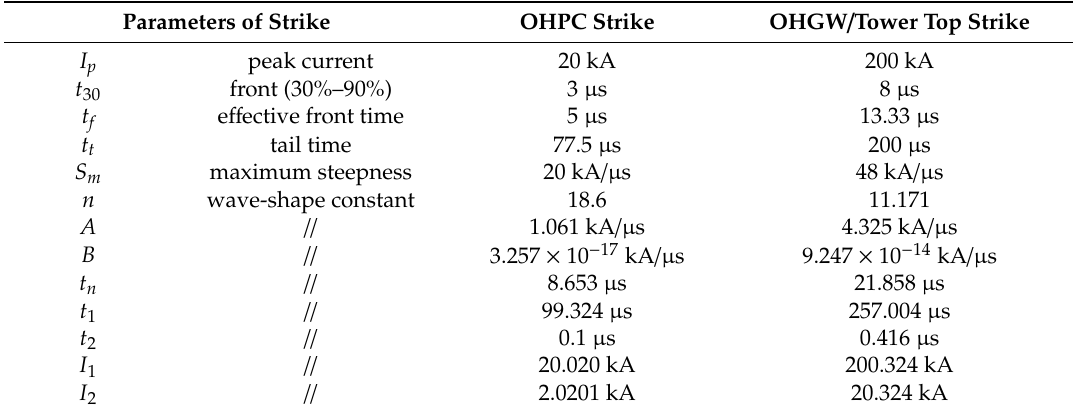
Figure 4. Upwardly concave front lightning current wave shape [27]. Table 2. Lightning impulse current